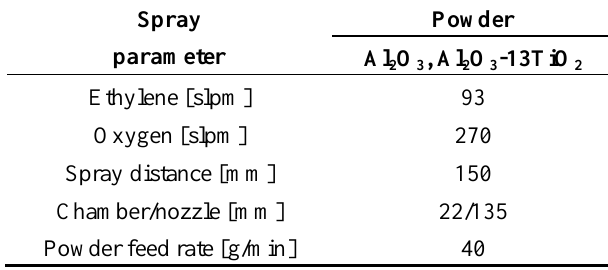
Table 2. Spray parameters for high-velocity oxygen fuel (HVOF).